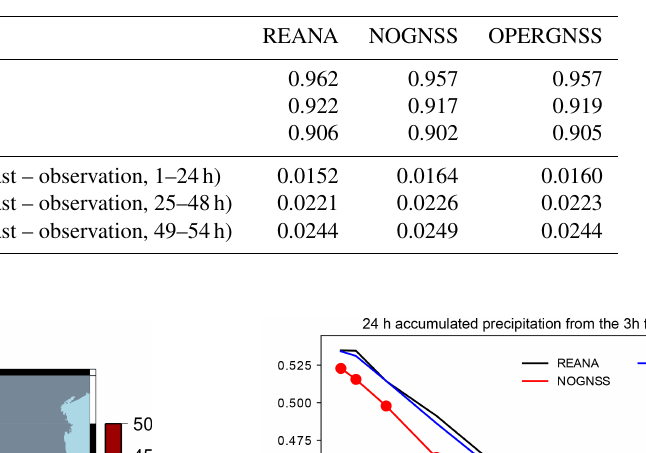
Table 5. Correlation and standard deviation of ZTD (in m) between AROME-WMED forecasts and reprocessed GNSS observations averaged over forecast ranges.